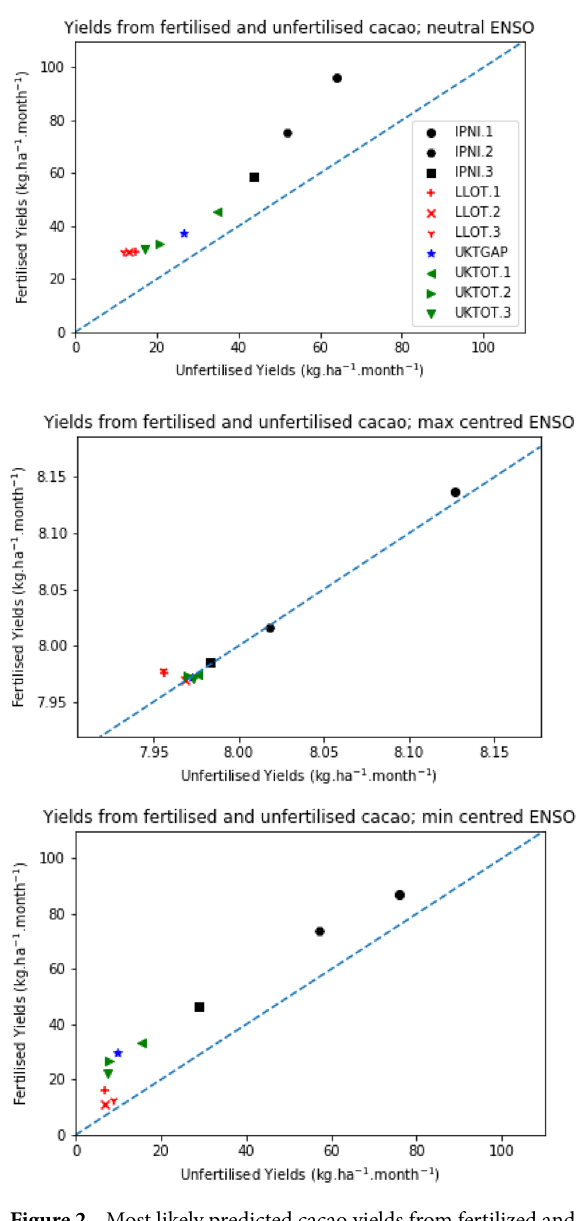
Figure 2. Most likely predicted cacao yields from fertilized and unfertilized crops under three contrasting ENSO OI profiles over the 9 months prior to harvest: ( a ) continuous neutral ENSO OI conditions; ( b ) ENSO OI conditions centred around the maximum observed value; and ( c ) ENSO OI conditions centred araound the minimum observed value. The dashed blue line indicates a 1:1 relationship between fertilized and unfertilized yields. Note the differente scale utilised for plot ( b ) (ENSO OI conditions centred around the maximum observed